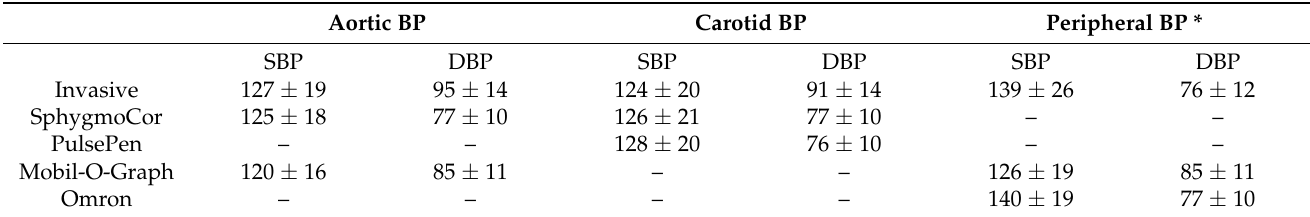
Table 2. Invasive and noninvasive blood pressure parameters.